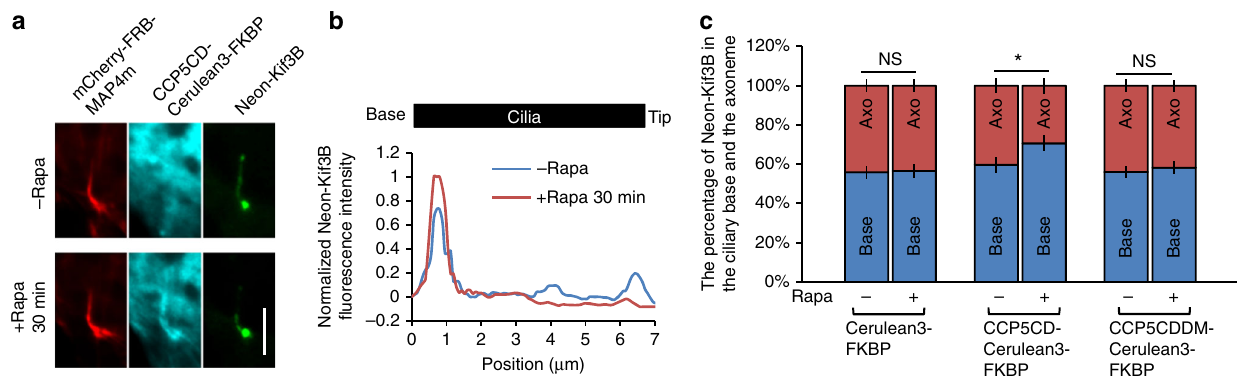
Fig. 6 Kinesin-2 accumulates at the base of deglutamylated cilia. a Neon-Kif3B-stable NIH3T3 cells were transfected with CCP5CD – Cerulean3 – FKBP – P2A – mCherry – FRB – MAP4m. Transfected cells at 80 – 90% con fl uency were serum-starved for 24 h and then treated with 100 nM rapamycin for 30 min. Scale bar, 4 μ m. b Linescan pro fi le of Neon-Kif3B from the base to the tip of the cilium in a . c Neon-Kif3B-stable NIH3T3 cells were transfected with P2A-based constructs for co-expression of mCherry – FRB – MAP4m and Cerulean3 – FKBP-tagged proteins. Transfected cells at 80 – 90% con fl uency were serum-starved for 24 h and then treated with or without 100 nM rapamycin for 30 min. The percentage of Neon-Kif3B at the base (Base) or axoneme region (Axo) of control or deglutamylated cilia is plotted. Data represent the mean ± s.e.m. ( n = 74, 48, and 69 cells for the Cerulean3 – FKBP, CCP5CD – Cerulean3 – FKBP, and CCP5CDDM – Cerulean3 – FKBP groups, respectively; three independent experiments). NS and * indicate no signi fi cant difference and P < 0.05, respectively, between the conditions in the presence and absence of rapamycin (Student's t